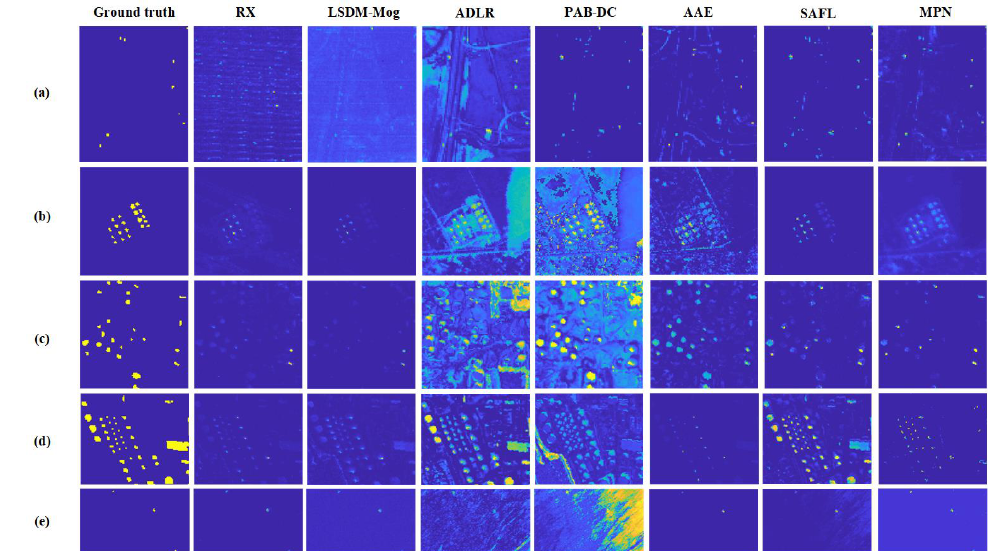
Figure 6. Detection results of MPN and the compared methods for ( a ) HYDICE, ( b ) ABU-urban1, ( c ) ABU-urban2, ( d ) EI Segundo, and ( e ) Grand